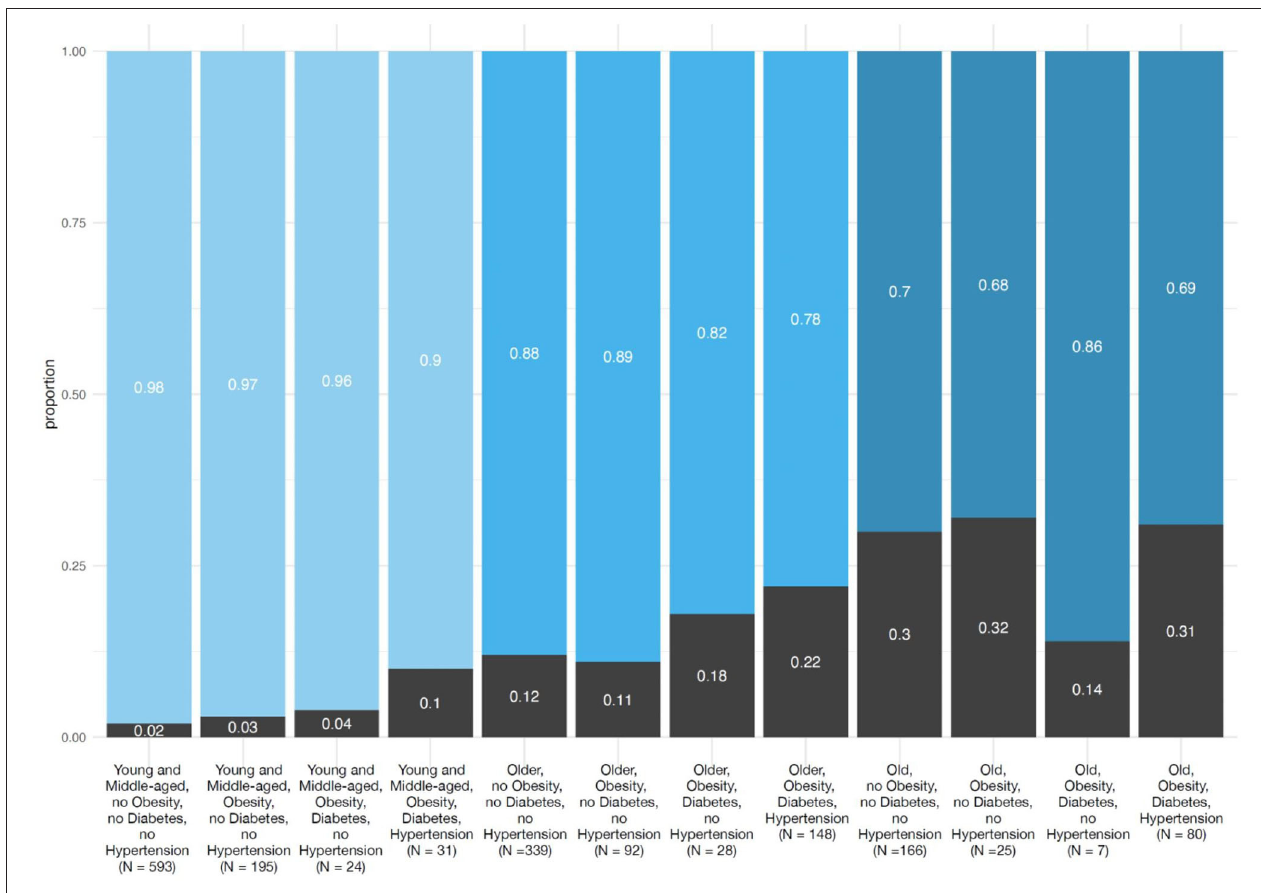
FIGURE 1 | Proportion of COVID-19 patients who recovered and died divided in three age groups based on the presence or absence of obesity, diabetes and hypertension. All COVID-19 patients who recovered and died ( n = 3,163) were first divided in three age groups (young and middle aged, 18–55 years, n = 1,068; older age, 56–75 years; n = 1,220 and old age, > 75 years; n = 875) and subsequently divided in four groups based on the presence or absence of obesity (BMI ≥ 30 kg · m − 2 ), and impaired metabolic health (diabetes and